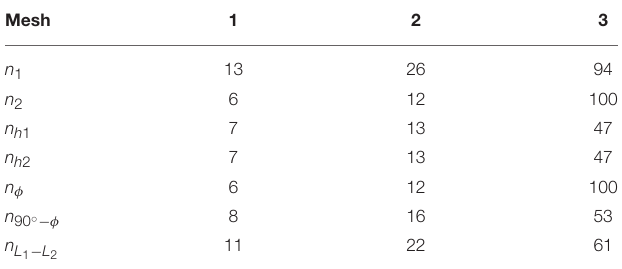
TABLE 6 | Values for the variables n i defining the different meshes. Mesh